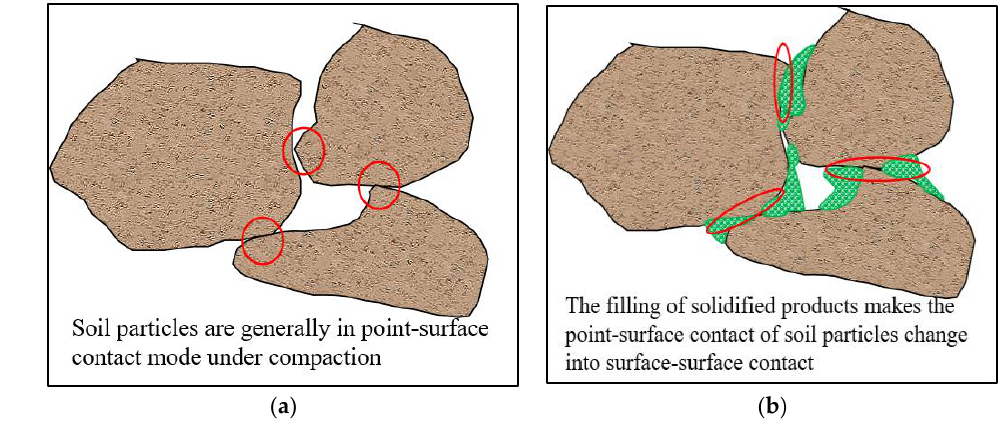
Figure 15. Transformation of the contact pattern of soil particles of ( a ) point–surface contact, ( b ) surface–surface contact.